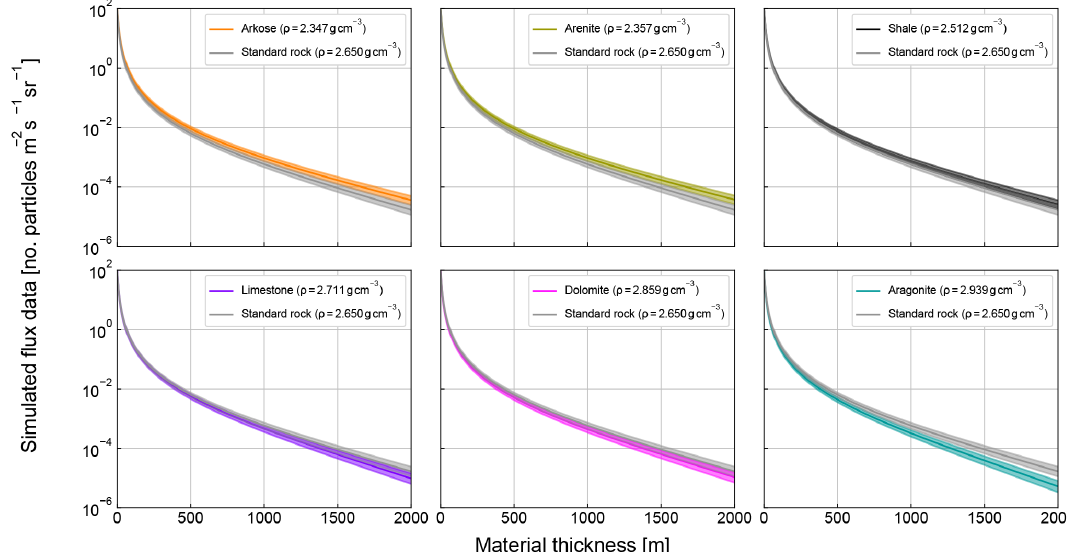
Figure 3. Simulated muon intensity vs. thickness of the six sedimentary rocks from Table 1 and standard rock. The mean flux is indicated by a bold line and 1 σ bounds are indicated by the shaded